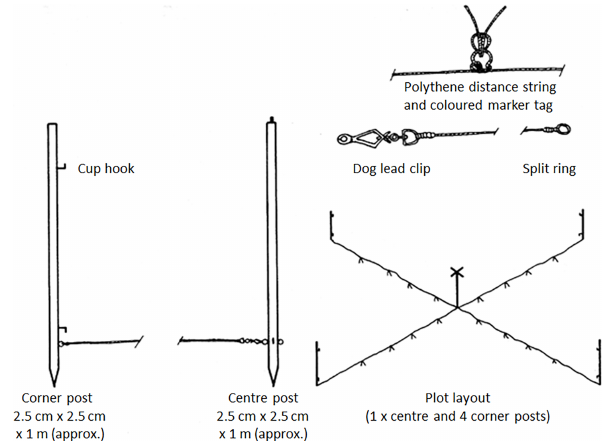
Figure 3. X plot